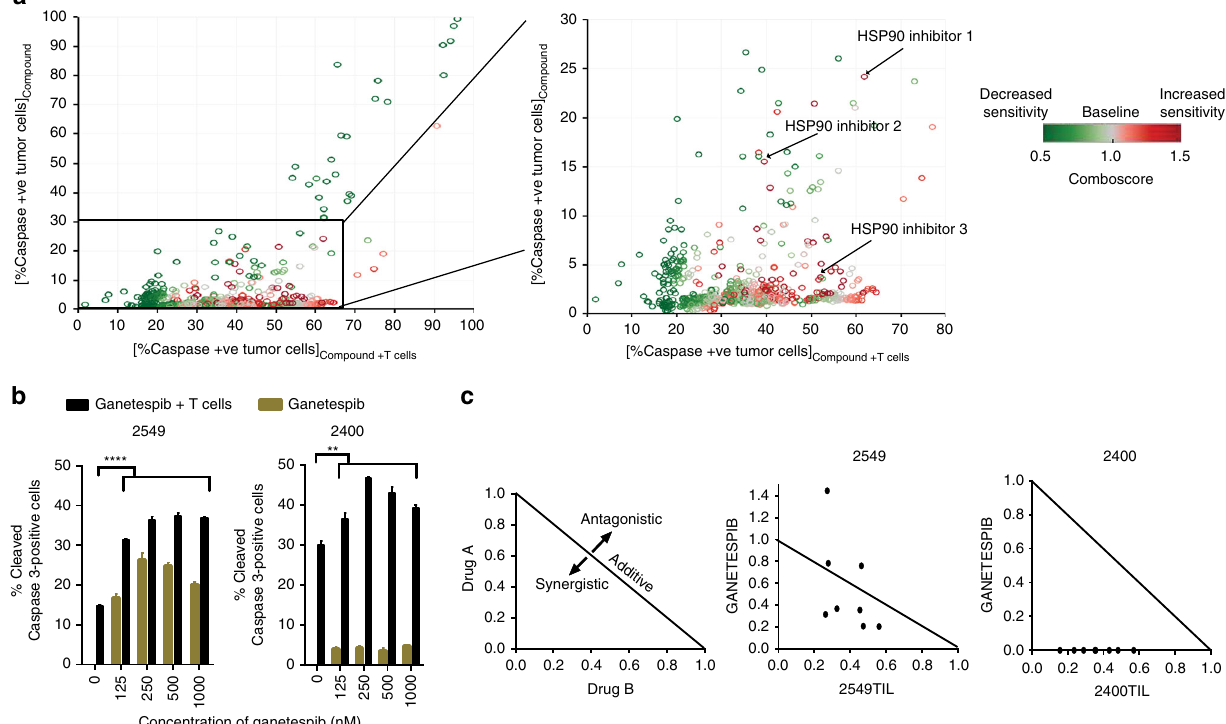
Fig. 1 HSP90 inhibition enhances T-cell mediated killing of melanoma cells. a Tableau depiction of screen results from patient-derived cell line 2549. HSP90 inhibitors 1 — 17-DMAG, 2 — BIIB021 and 3 — 17-AAG are highlighted. b Cleaved caspase 3 percentage following treatment with varying concentrations of ganetespib and autologous TILs in human melanoma cell lines 2549 and 2400. c Isobolograms depicting the synergism between ganetespib and T-cell killing. Points > 1 indicate antagonism, points = 1 indicate additivity and points < 1 indicate synergism. An unpaired two tailed Student t -test was performed with ** P < 0.01; **** P < 0.0001. Data are a representation of at least two independent